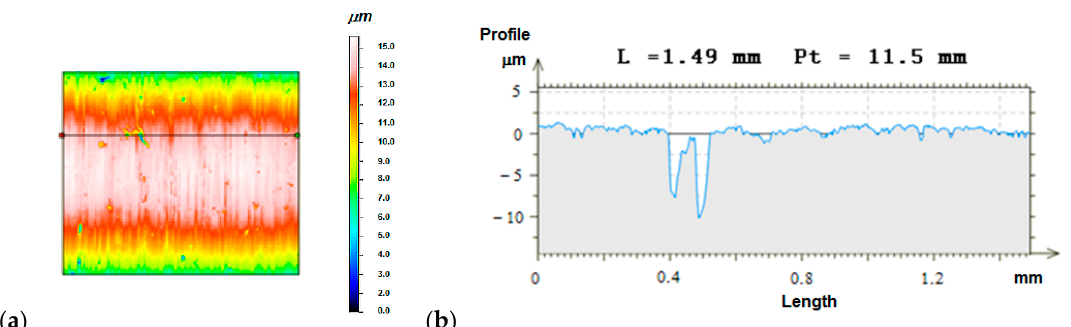
Figure 13. Contour map of the burnished surface of the plasma sprayed composite coatings together with the surface roughness profile. ( a ) topography of the burnished surface, ( b ) surface roughness profile.